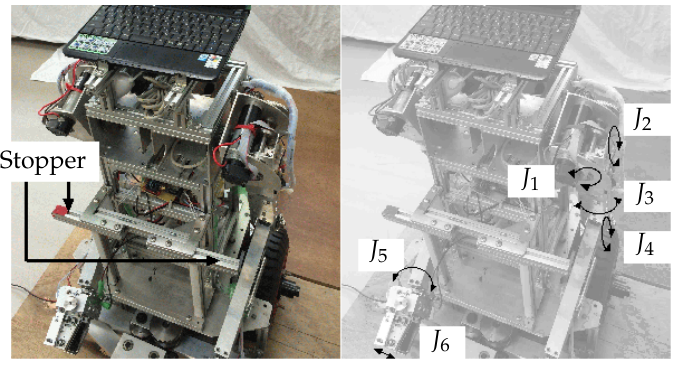
Figure 6. Robot pushing against the bottom of a hand cart using the front-wheel mechanism.